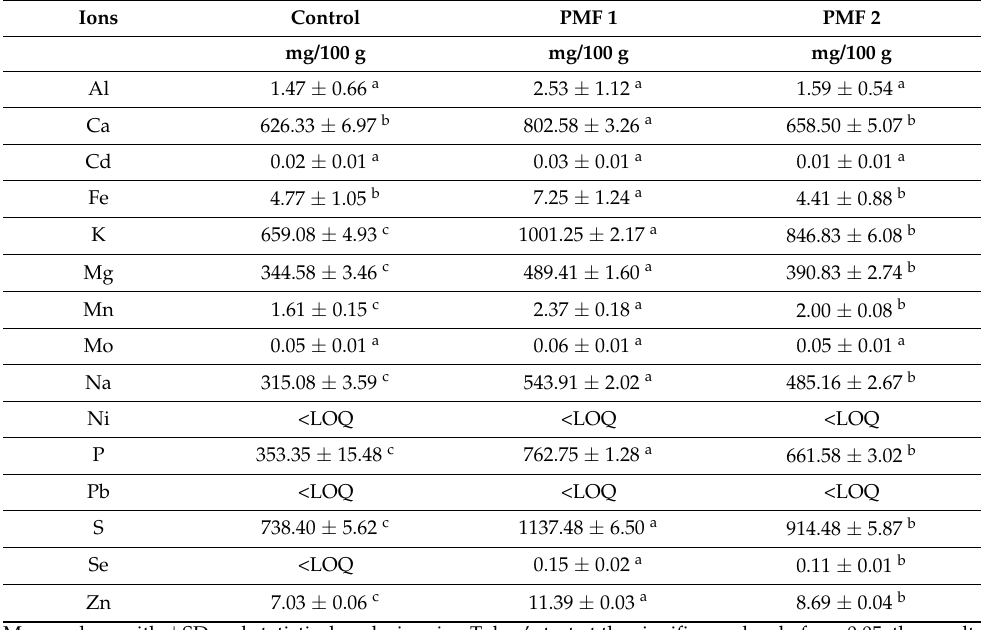
Table 3. Changes in the content of basic micro and macro components and heavy metals under the influence of applied pulsed magnetic fields for radish